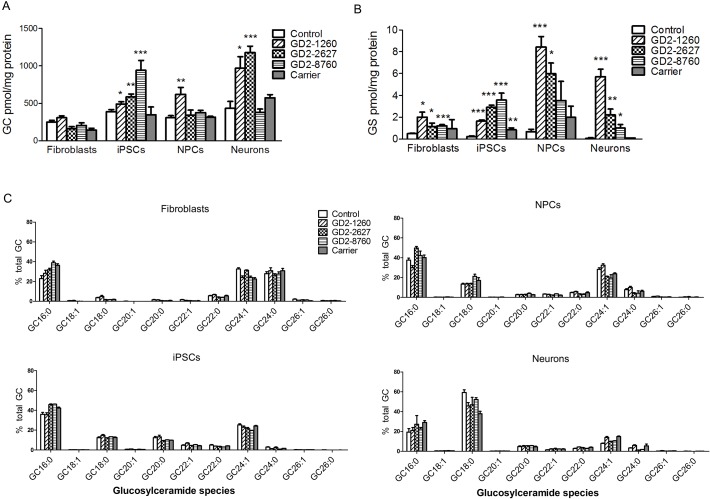
Glycosphingolipids analyses of substrate accumulation by LC/MS.(A) Glucosylceramide (GC) was increased in GD2-8760 iPSCs, GD2-1260 NPCs and neurons and GD2-2627 neurons (14 d) compared to controls. There was no significant difference in glucosylceramide levels between GD2 and control fibroblasts. (B) Glucosylsphingosine (GS) levels were increased in GD2 fibroblasts, iPSCs, NPCs and neurons (14 d) compared to control cells. Glucosylceramide and glucosylsphingosine levels in fibroblasts, iPSCs and NPCs were normalized by protein level in cell lysate. Student’s t test (*, p<0.05; **, p<0.01; ***, p<0.0001). Data are Mean±S.E. (n = 3–10). (C) Glucosylceramide species. Proportion of each species analyzed by LC/MS was quantified and compared to total glucosylceramides (n = 3–12). Profiles of glucosylceramide species were distinct in each cell type. The profile of the accumulated glucosylceramides in GD2 cells corresponded to the species found in each of the control cell types.